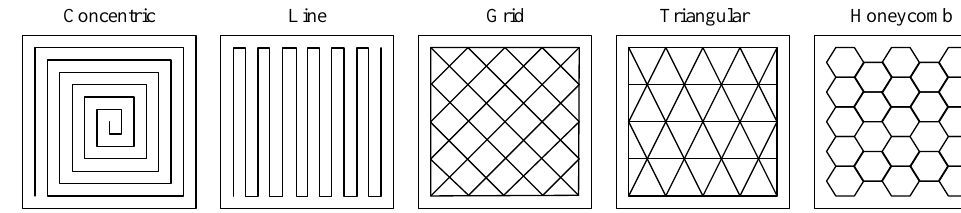
Figure 6. Typical in-fill